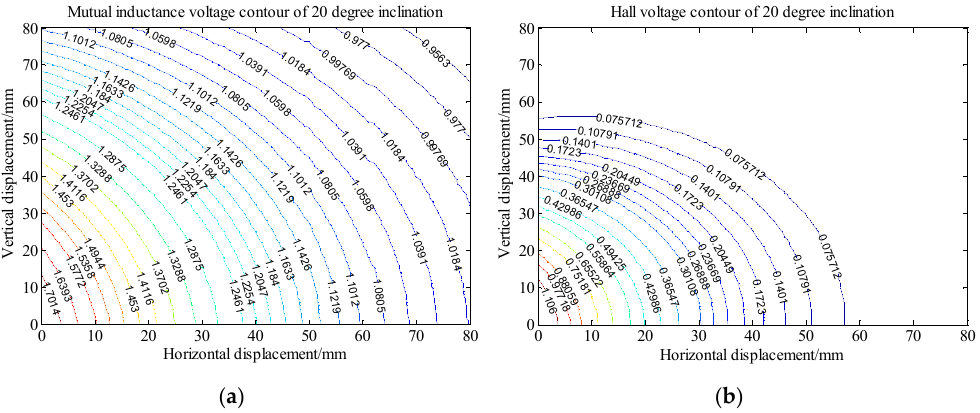
Figure 12. Voltage contour at 20 o inclination. ( a ) Mutual inductance voltage contour; ( b ) Hall voltage contour.